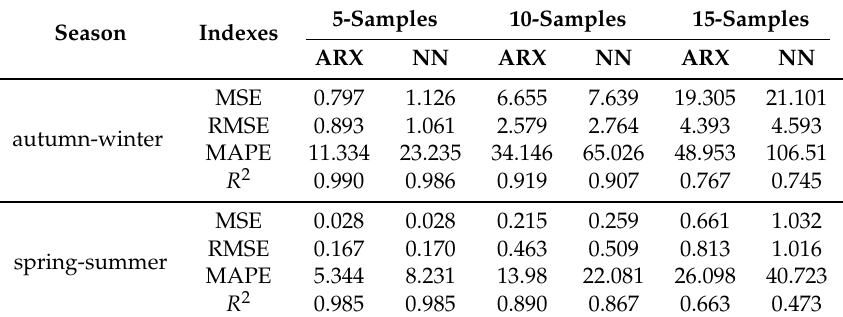
Figure 9. Results for one day during the autumn-winter season from the ARX model and the neural network model with a ( a ) 5-, ( b ) 10- and ( c ) 15-sample prediction horizon; and for one day during the spring-summer with a ( d ) 5-, ( e ) 10- and ( f ) 15-sample prediction horizon for the greenhouse. ( ) Measured, ( ) ARX model, ( ) NN model. Table 5. Performance indexes for the greenhouse prediction model with 5-, 10- and 15-sample prediction